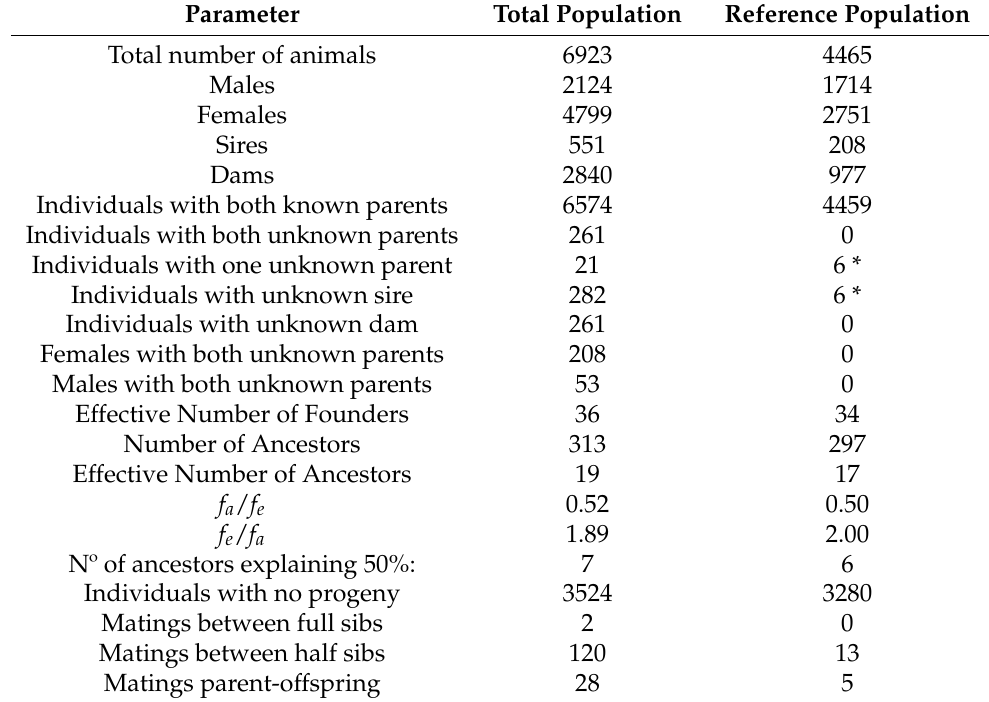
Table 1. Pedigree structure of the Murgese horse.